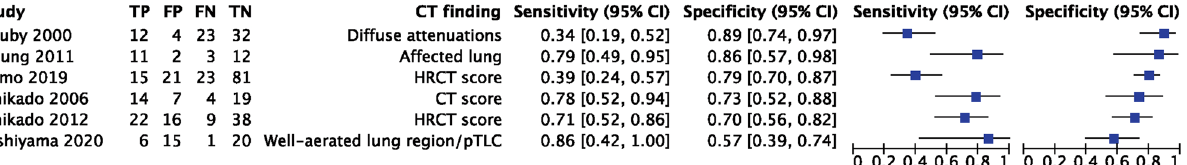
Figure 3. Paired forest plot. TP, true positive; FP, false positive; TN, true negative; FN, false negative; CT, computed tomography; HRCT, high resolution computed tomography; pTLC, predicted total lung capacity; CI, confidence